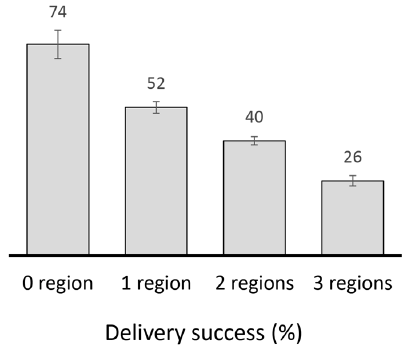
Figure 10. Percentage of successful delivery for messages traversing 0, 1, 2 and 3 regions under high degree of spatial locality with SnF (L = 8).